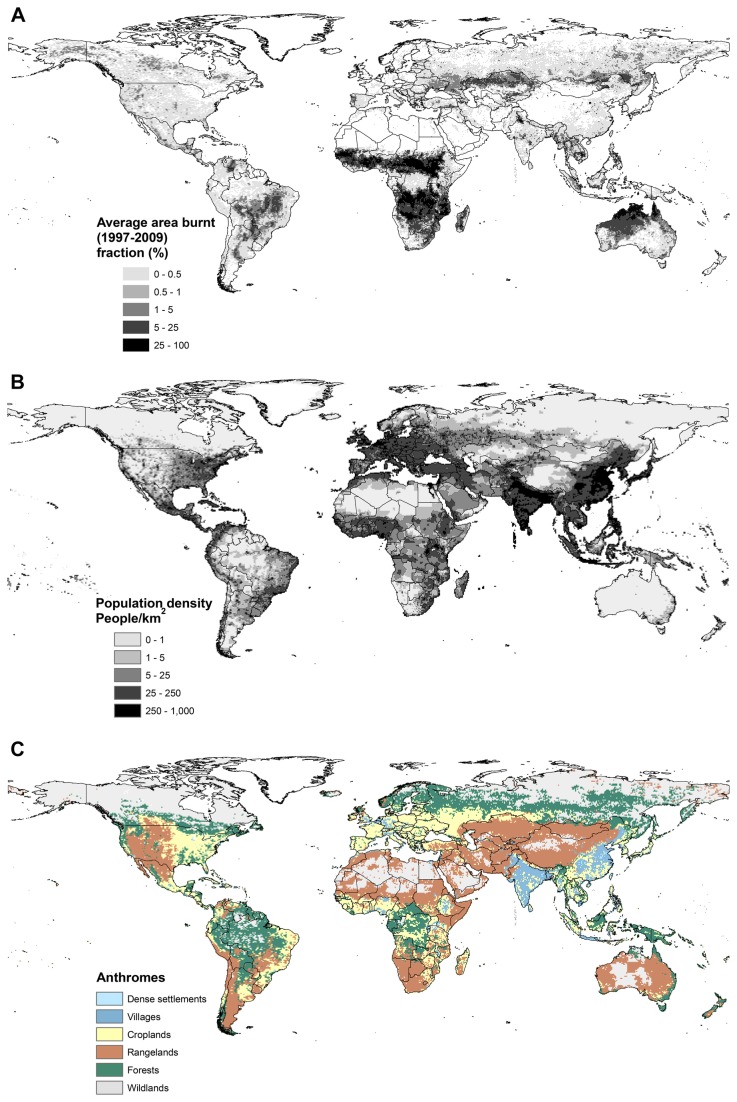
Input data sets.Average mean annual burned area (showed in cell area fraction instead of km2 in order to help the interpretation), based on data from the Global Fire Emissions Database version 3 (GFED3: Giglio et al., 2010) for the period 1997-2009; (B) Population density (persons per square kilometre: p/km2) from the Gridded Population of the World version 3 (Ciesin, 2005); and (C) The anthropogenic biomes (anthromes) of the world, mapped as the six major anthrome types (see Table 1) defined by Ellis and Ramankutty (2008).